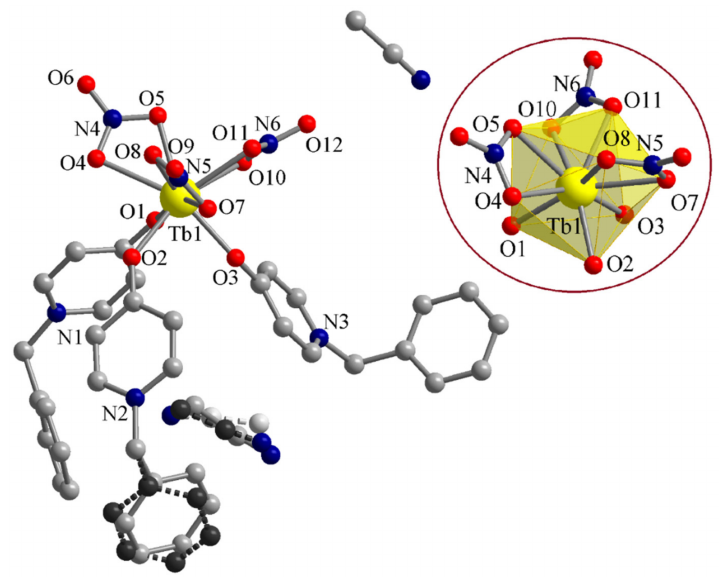
Figure 1. Molecular structure of the compound 5c · 2CH 3 CN (the hydrogen atoms were omitted for clarity). The phenyl ring depicted with dark gray and dotted lines represents the crystallographic position with a site occupancy factor of 0.3. The inset shows a detail of the coordination environment of the metal